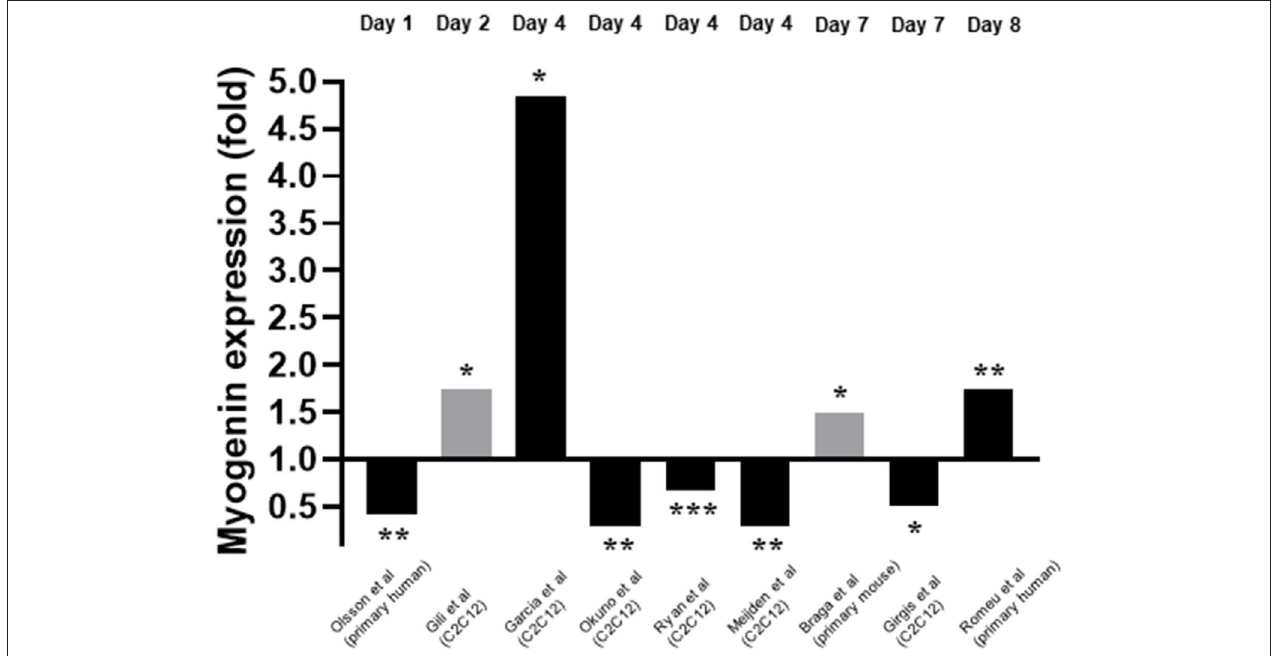
FIGURE 5 | Effect of 1,25(OH) 2 D 3 of Myogenin expression. The active form of vitamin D [1,25(OH) 2 D 3 ] at 10 − 7 M was used in all studies apart from Gili et al. (2016) where 10 − 8 M was used. Black bars indicate mRNA expression whilst grey indicates protein expression. * p < 0.05, ** p < 0.01, *** p < 0.001.